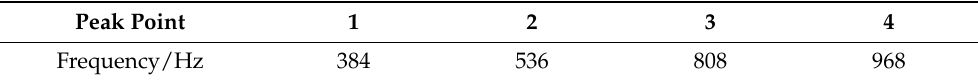
Table 4. Peak response